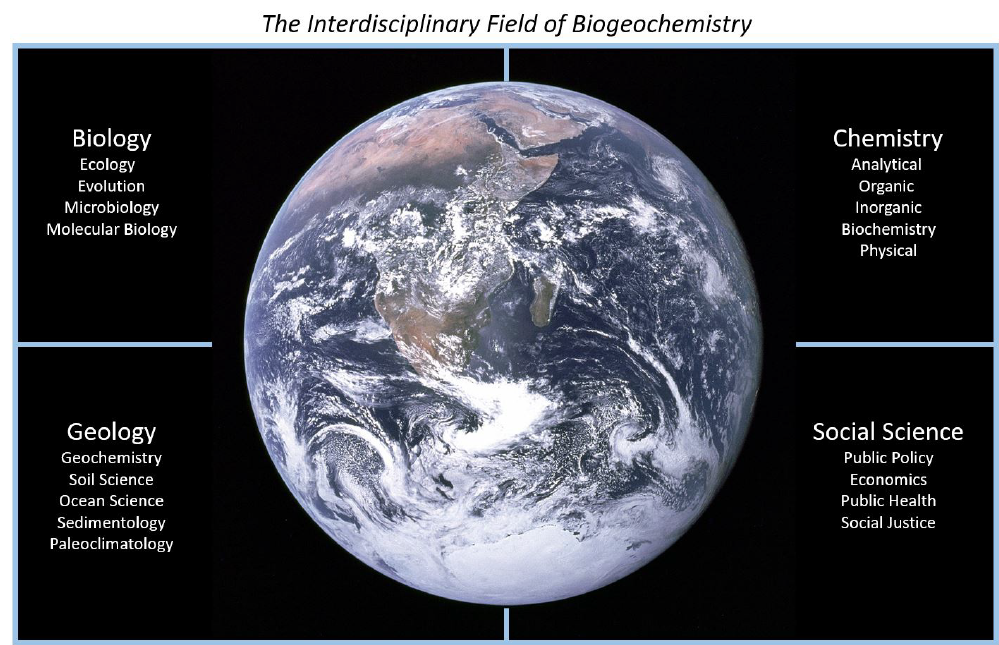
Figure 1. The interdisciplinary field of biogeochemistry has advanced with expanded approaches that involve the integration of core biogeo- chemical areas with other disciplines needed to understand a rapidly changing Earth system and meet the needs for